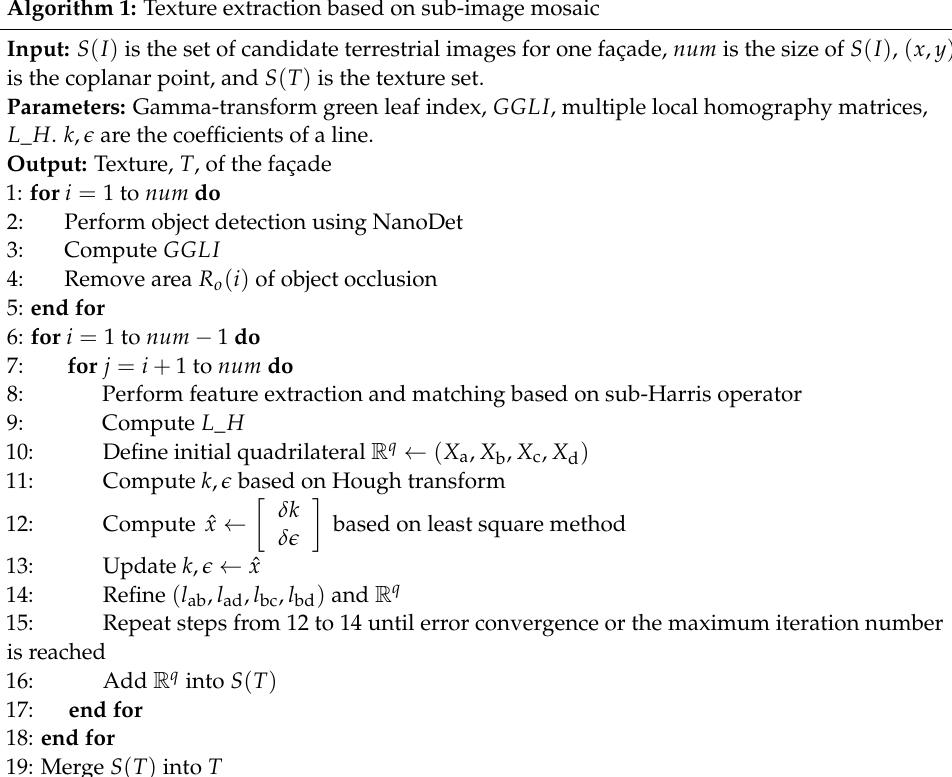
Algorithm 1: Texture extraction based on sub-image